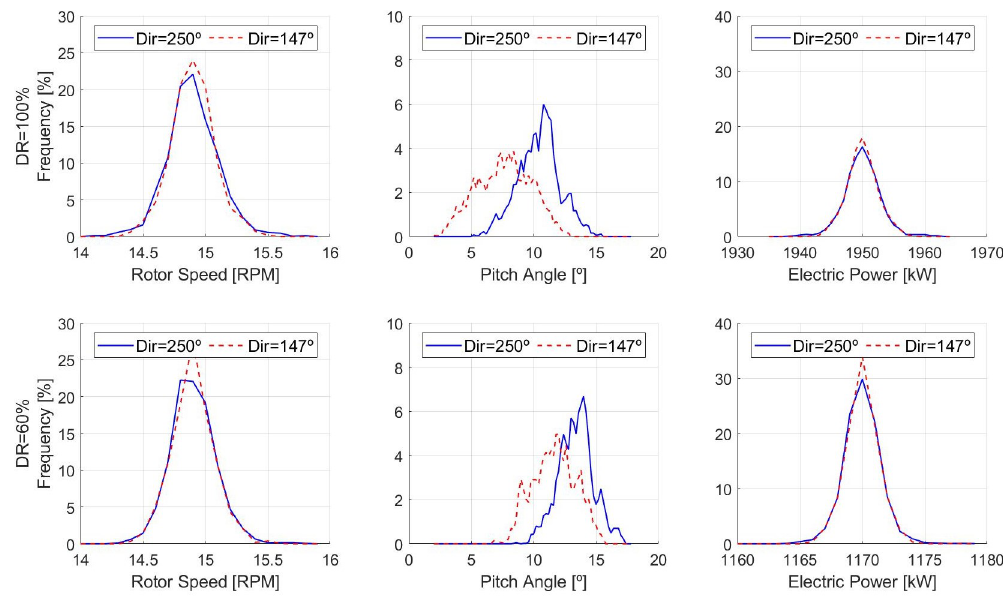
Figure 10. WT3 operation. Inflow condition of the simulations: Wind direction 250 ◦ and wind direction 147 ◦ (without and with wake interaction respectively) and wind speed above rated. Two constant de-rated signals applied, 100% ( top ) and 60% ( bottom